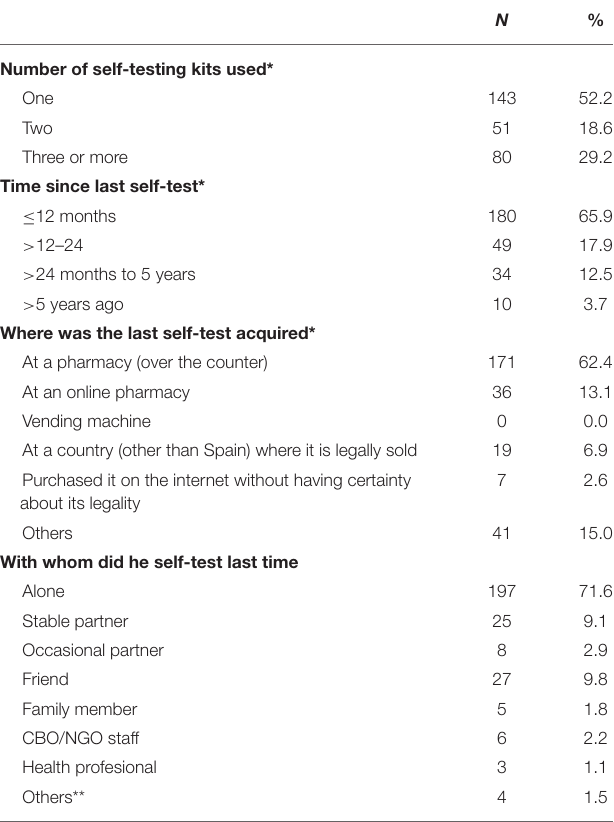
TABLE 4 | Number of self tets performed, times since last self-testing episode, place of acquisition and company during last episode among participants who reported having used a self-test in the past ( N =